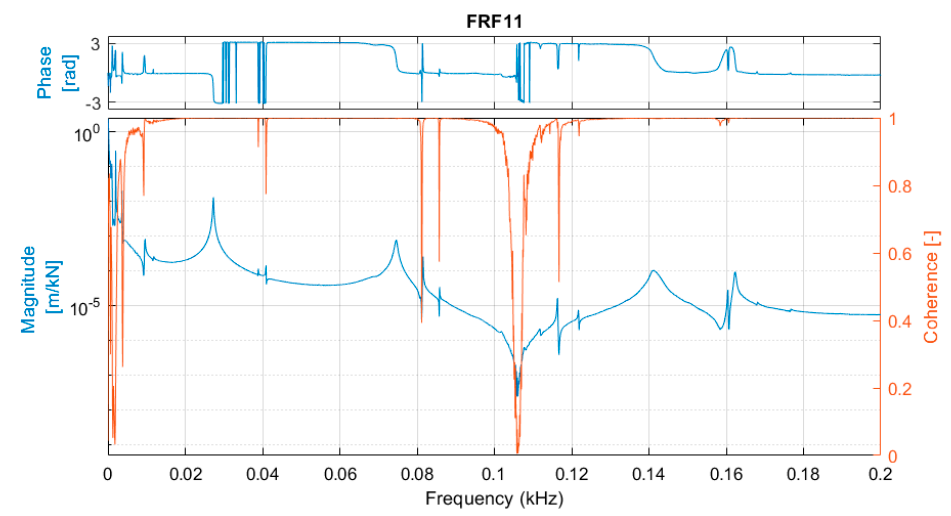
Figure 6. The exemplary frequency response functions (FRFs) of the analyzed beam UHPC2_L in configuration 1.